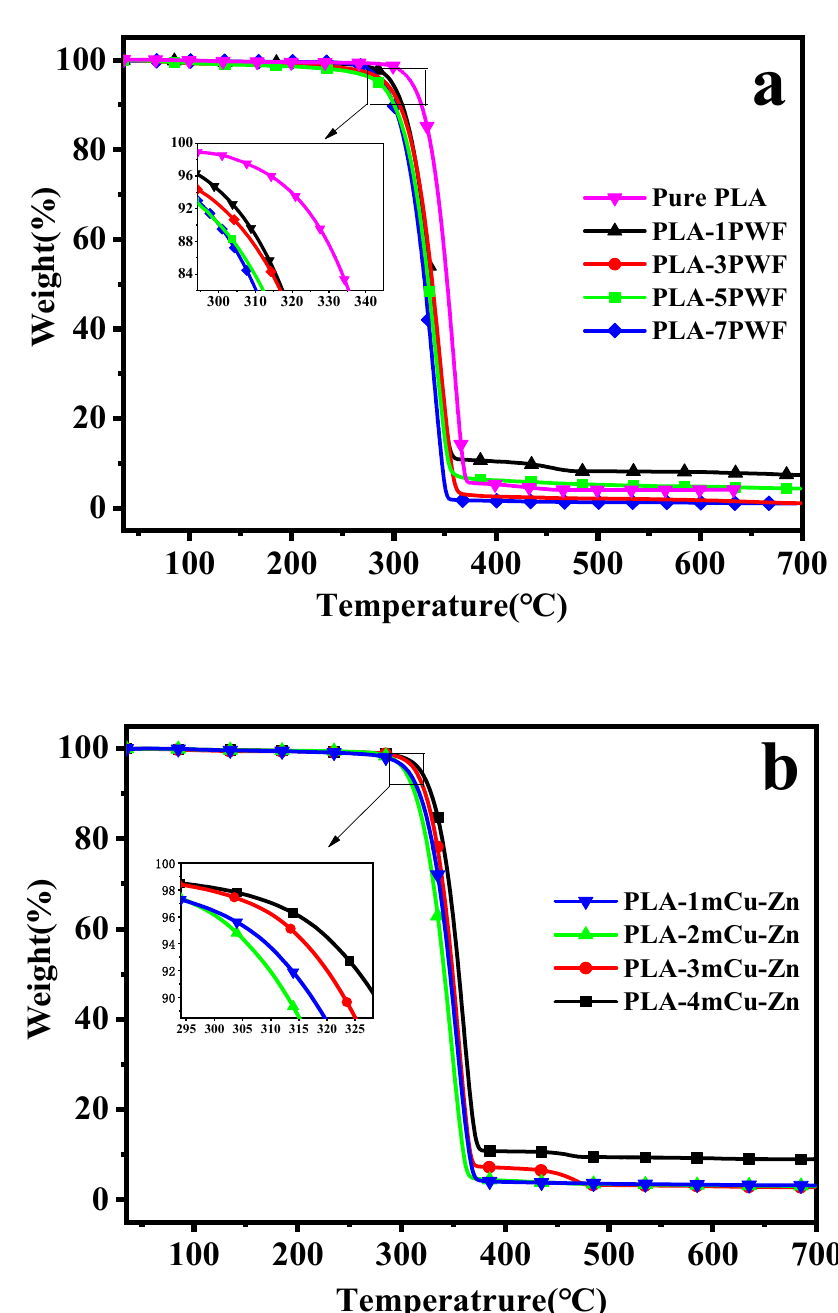
Figure 8. Thermal gravity analysis (TGA) curves of PWF / PLA composites ( a ) and mCu-Zn / PWF / PLA composites with 5 wt.% PWF ( b ).